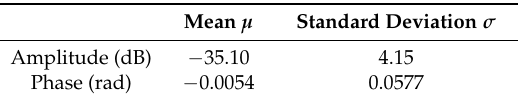
Table 3. Calibration